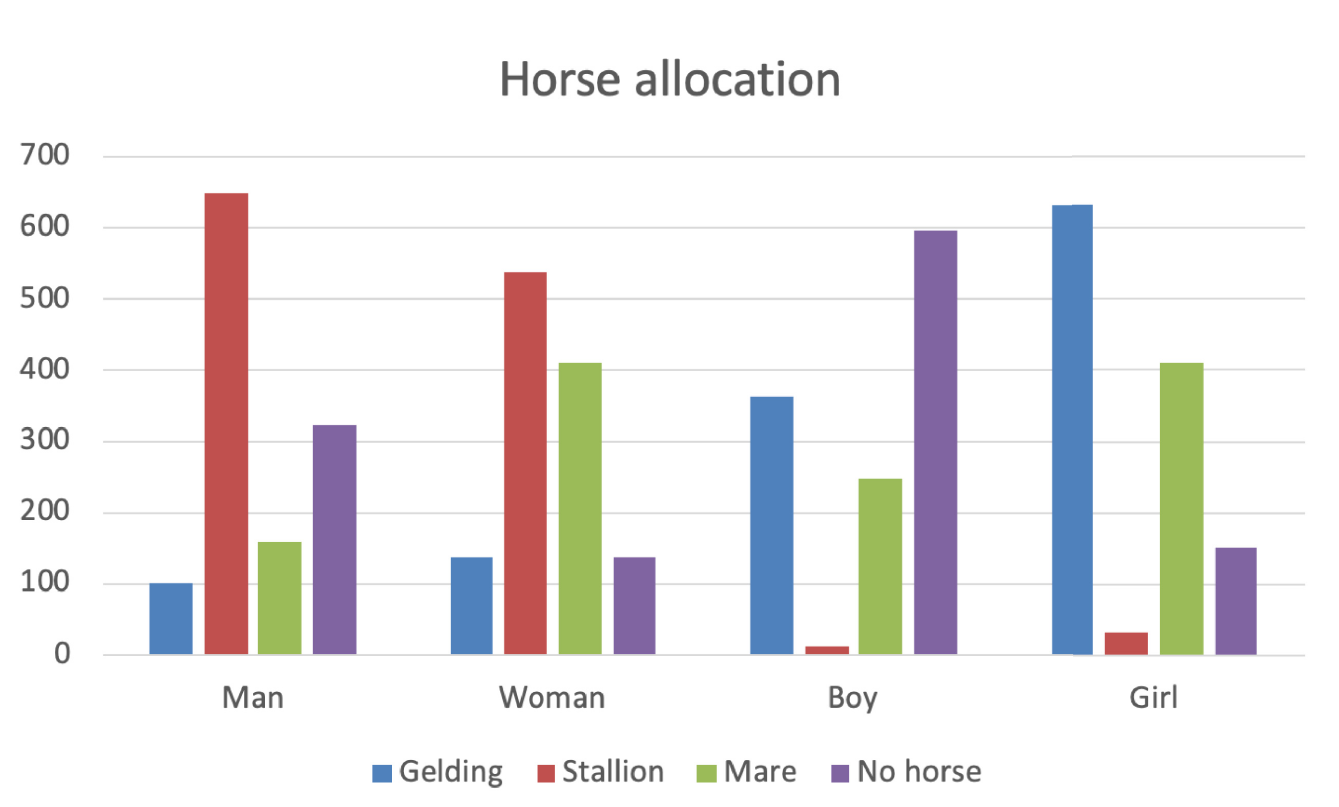
Fig 2. Horse allocation. Respondents (n = 1233) assigned either a gelding, stallion or mare to the man, woman, boy and girl, leaving one rider without a horse. The man was not allocated a horse twice as often as the woman and the girl and the boy was not allocated a horse most frequently.